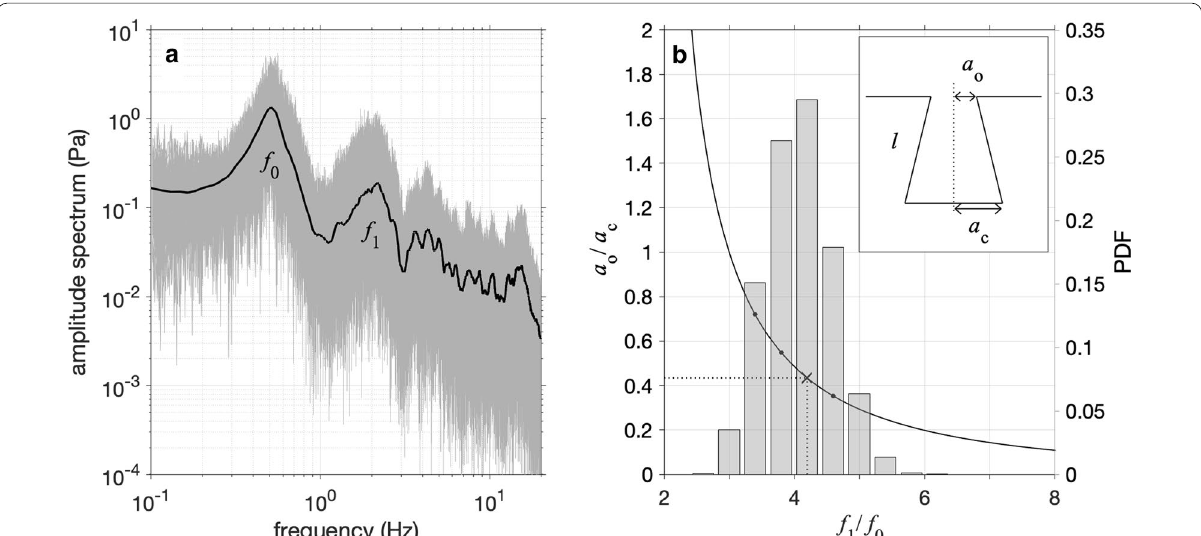
Fig. 2 Observed infrasound spectrum and distribution of its frequency ratio. a Amplitude spectra of the infrasound signals, calculated with 10-min waveforms. Gray lines show amplitude spectra provided from the data every 10 min of the 9-h subject period, and the black line is a smoothed spectrum of their average. The distinct peak is shown at ∼ 0.5 Hz ( f 0 ), and some additional peaks exist at higher frequencies. The prominent peak among them is ∼ 2 Hz, corresponding to overtone f 1 of the acoustic resonance. b Distribution of the observed frequency ratio ( f 1 / f 0 ) and theoretical relationship between the frequency ratio and frustum radius ratio. The observed frequency ratio was calculated from the average amplitude spectrum of a (Additional file 3). The PDF of the frequency ratio is shown as a histogram. The black line is a theoretical relationship between the frequency ratio ( f 1 / f 0 ) and the radius ratio of the frustum of the open and closed ends ( a o / a c ), according to Ayers et al. (1985). The main four bins of the f 1 / f 0 histogram correspond to a o / a c values of 0.35, 0.43, 0.55, and 0.72 (dots and a cross on the black line). These values suggest that the shape of the space in the conduit widens as the depth increases. The PDF values of the four bins were used as weighting coefficients for the final summation of the